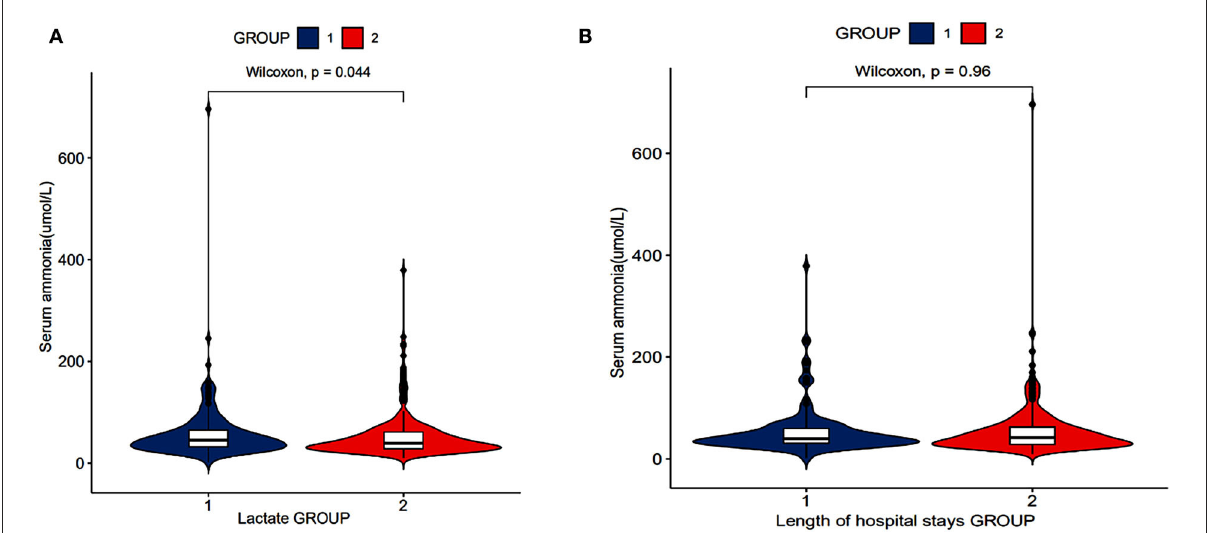
FIGURE3 Relationship between serum ammonia and length of hospital stays, lactates of patients with SAE (RStudio, Version 1.3.1056, USA). (A) The relationship between serum ammonia levels and lactate levels. (B) The relationship between serum ammonia levels and length of hospital stays.